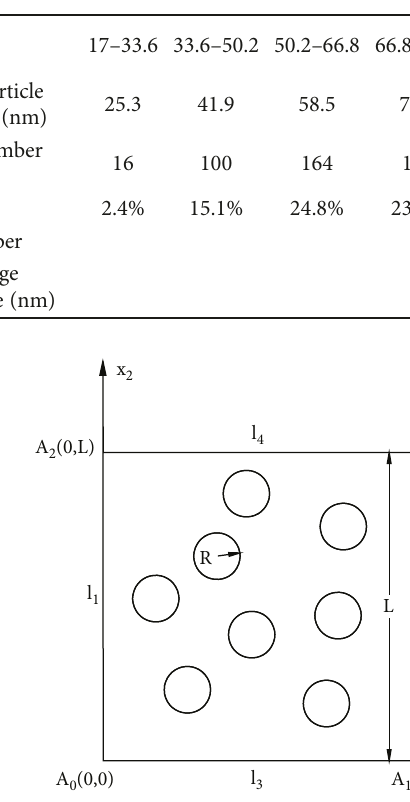
Table 2: Statistics results for particle size.